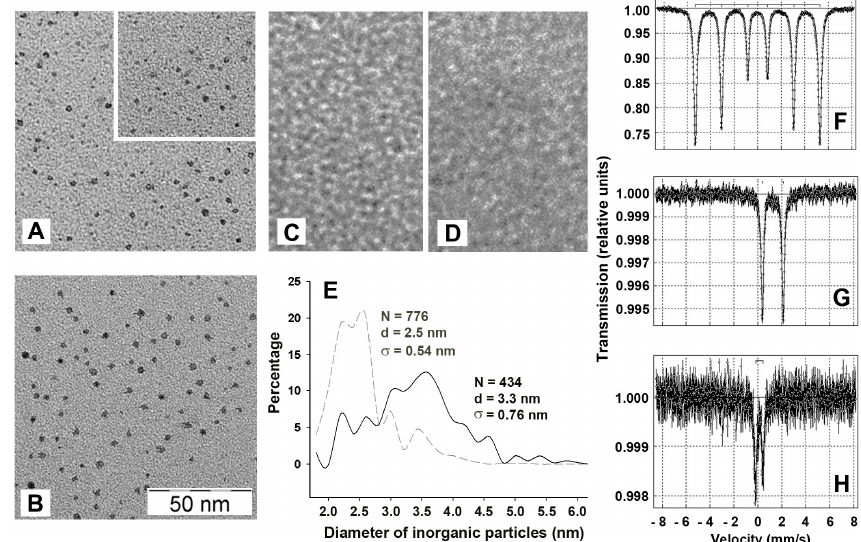
Figure 2. Characteristics of iron content in the inner cavity of Dps. ( A ) and ( B ) TEM images of inorganic particles taken from the native protein (1.64 μ M with 126 Fe-ions per dodecamer) and Dps, loaded with 1 mM of Fe(NH4) 2 (SO 4 ) 2 , respectively. Particles accounted for image analysis are countered by Altami Studio software (http://altamisoft.ru/products/altami_studio/). An insert in panel A shows an unprocessed image identical to the bottom part of the same panel. ( C ) apo-form of the Dps, prepared as described in Materials and Methods. ( D ) Image of 1 mM of Fe(NH4) 2 (SO 4 ) 2 alone. Scaling is identical for all images and is shown in ( B ). ( E ) Densitograms showing the size distribution of inorganic particles calculated with a resolution step of 0.2 nm. Dashed and solid lines correspond to native and iron-loaded proteins, respectively. N denotes the number of analyzed particles, d —average diameter of cores approximated by circles, σ —StD of d . ( F – H ) Mössbauer spectra obtained for α Fe, 1 mg of dry Fe(NH4) 2 (SO 4 ) 2 and for the Dps protein incubated with 1 mM Fe(NH4) 2 (SO 4 ) 2 .